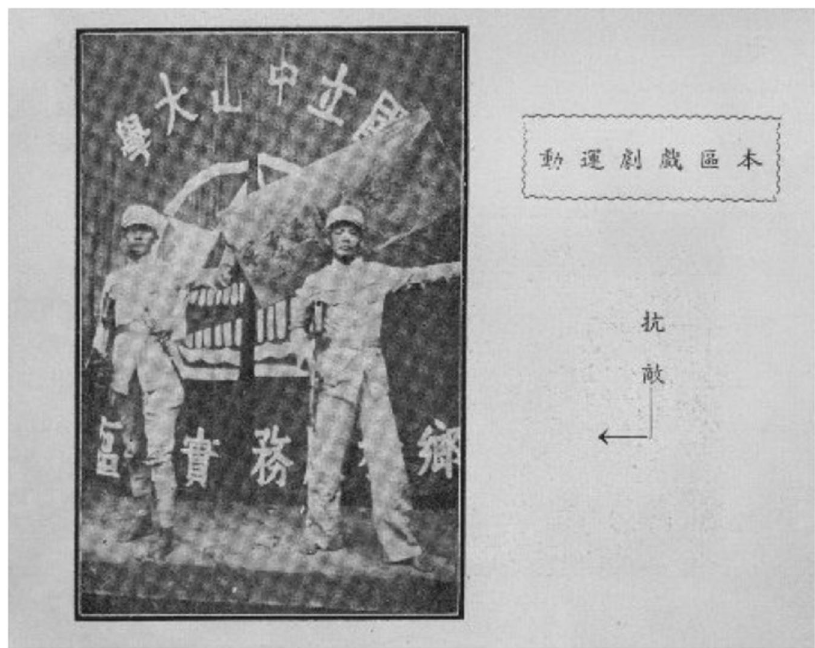
Fig. 4 Drama poster. The name of the drama is “ Resisting the Enemy ” , which is used to publicize Anti Japanese and national